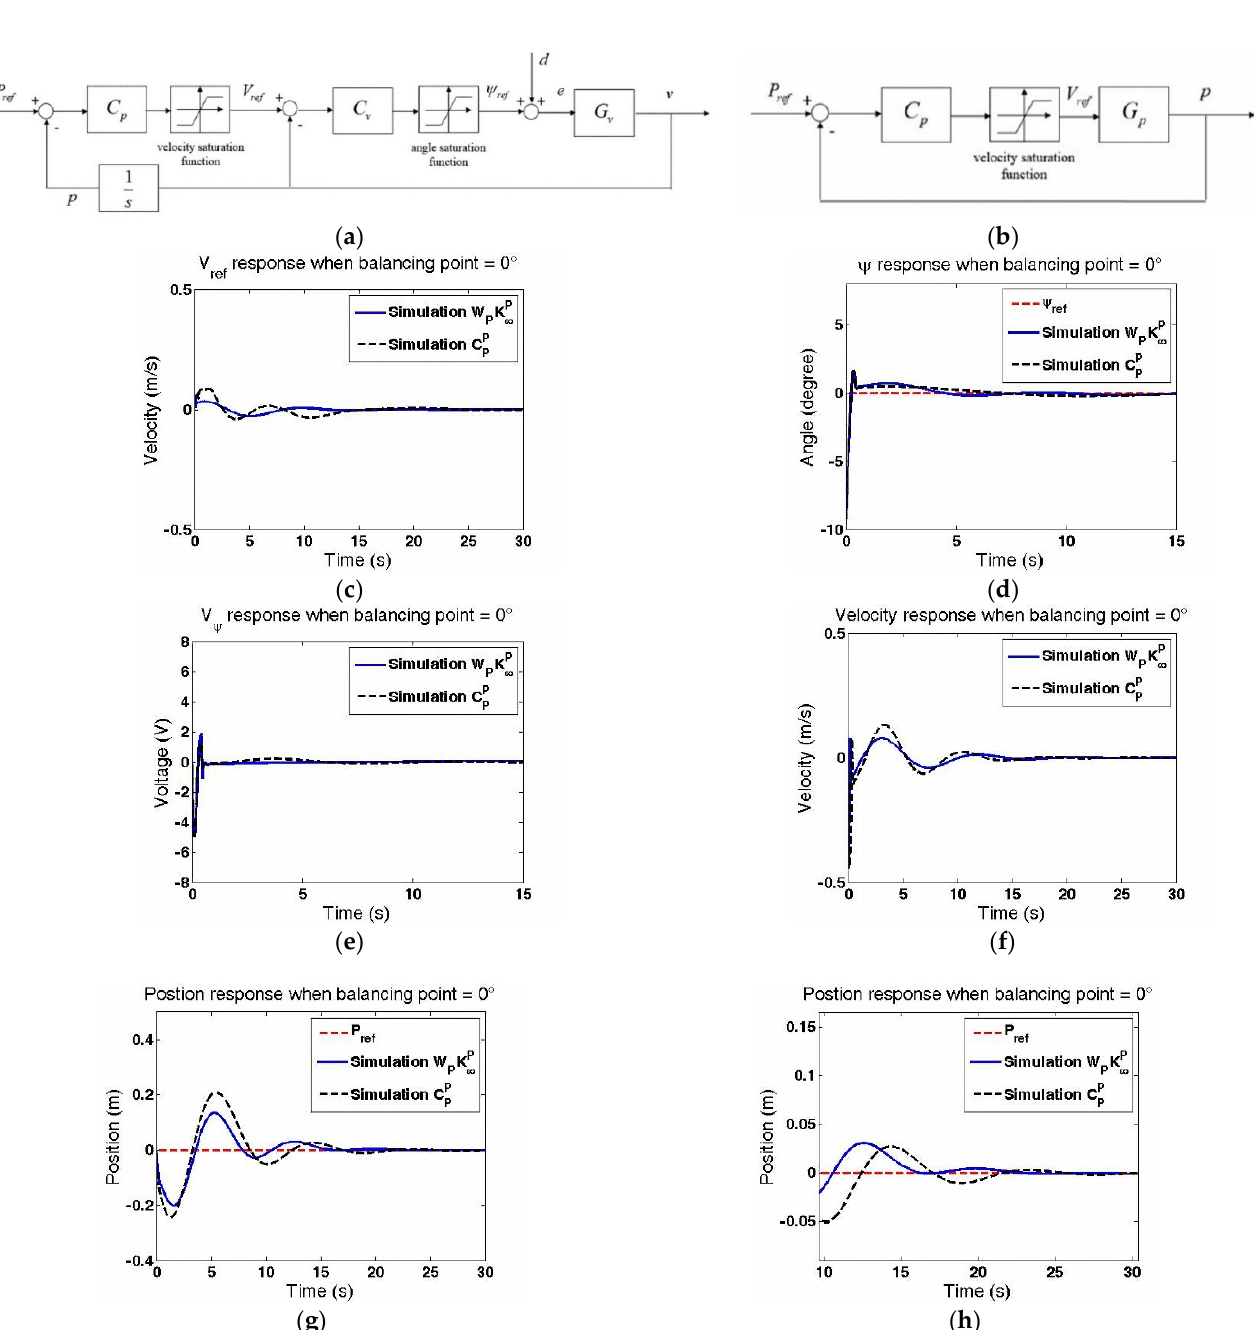
Figure 8. The position loop structure and simulation results with P ref = 0: ( a ) The position loop control structure; ( b) Simplification of the position loop structure; ( c ) Online V ref adjustment; ( d ) ψ responses; ( e ) control signal V ψ ( t ) ; ( f ) Velocity responses v ( t ) ; ( g ) Position responses p ( t ) ; ( h ) Zoom-in plot of ( g ).